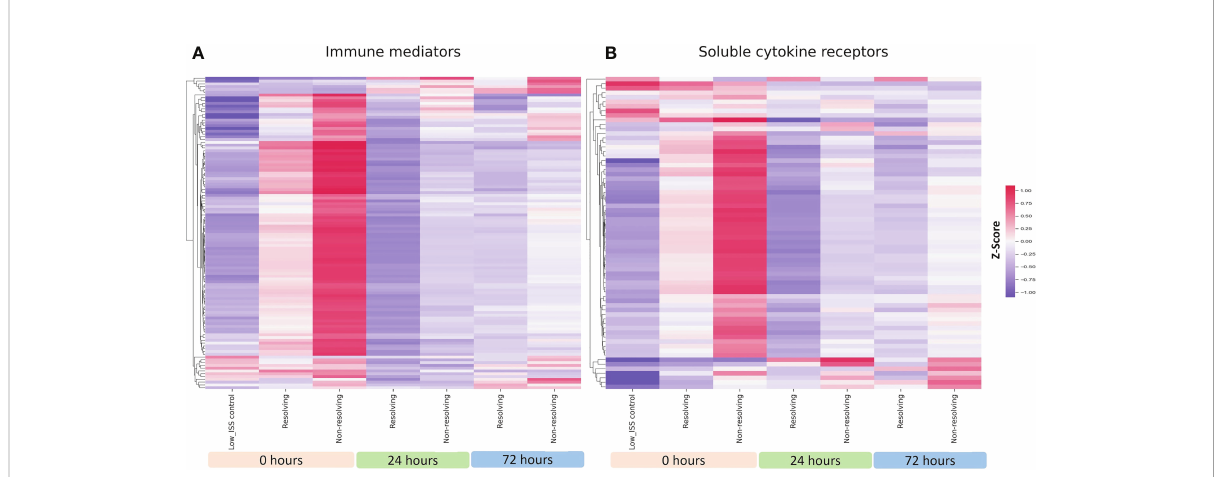
FIGURE 3 Heatmap illustrating normalized z-scores for all 115 assayed immune mediators (A) and 69 soluble cytokines (B) in ISS matched NR (n=39) and R (n=26) patients at 0, 24 and 72 h with low ISS (ISS of 1 or